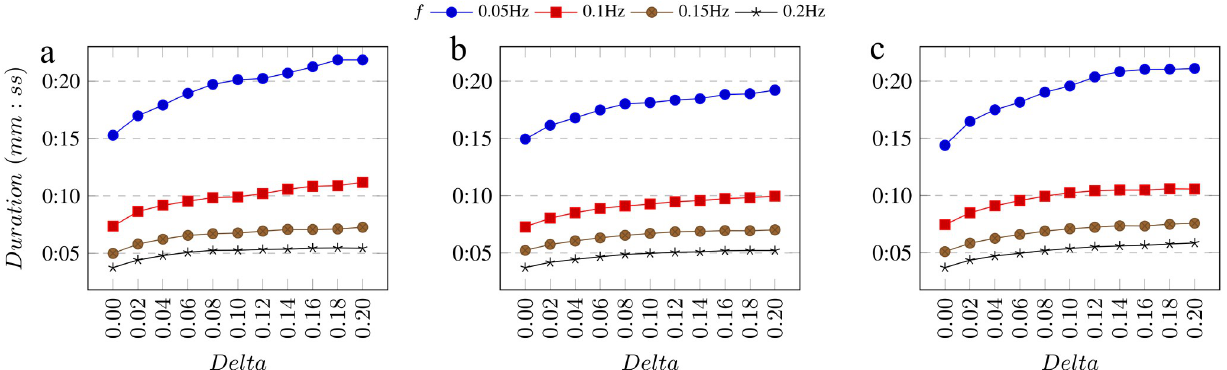
Fig 8. Average predicted segment duration. (A) For pupil width signal and (B) for difference signal on dataset A, (C) for pupil width signal on dataset B with different f and Delta .